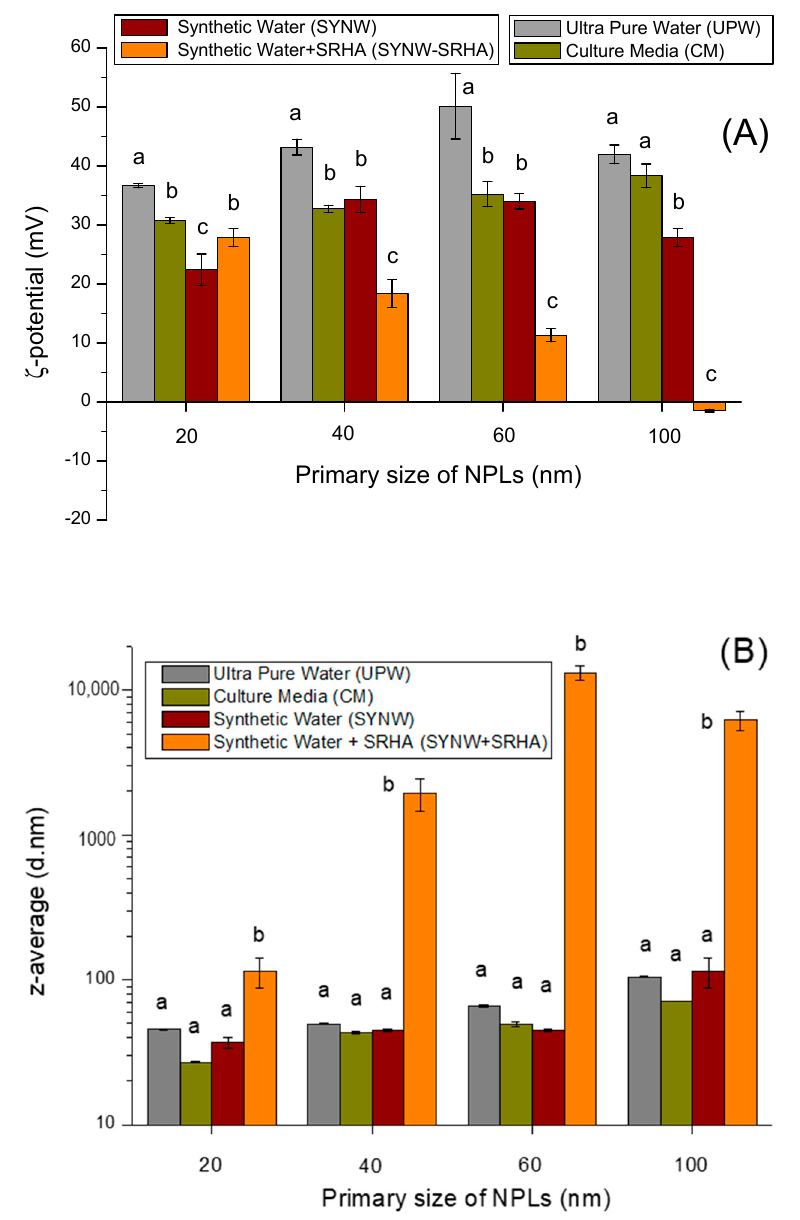
Figure 1. ( A ) ζ -Potentials and ( B ) z-average hydrodynamic diameters of polystyrene nanoplastics (NPLs) at a concentration of 50 mg/L as a function of primary sizes in ultra-pure water (UPW), culture media (CM), synthetic water (SYNW), and synthetic water spiked with SRHA (SYNW-SRHA) at a concentration of 1 mg/L. Letters (a,b,c) indicate statistically significant difference between treatments (pairwise multiple comparison procedures—Tukey’s test within each NPL size group, p -value < 0.05).